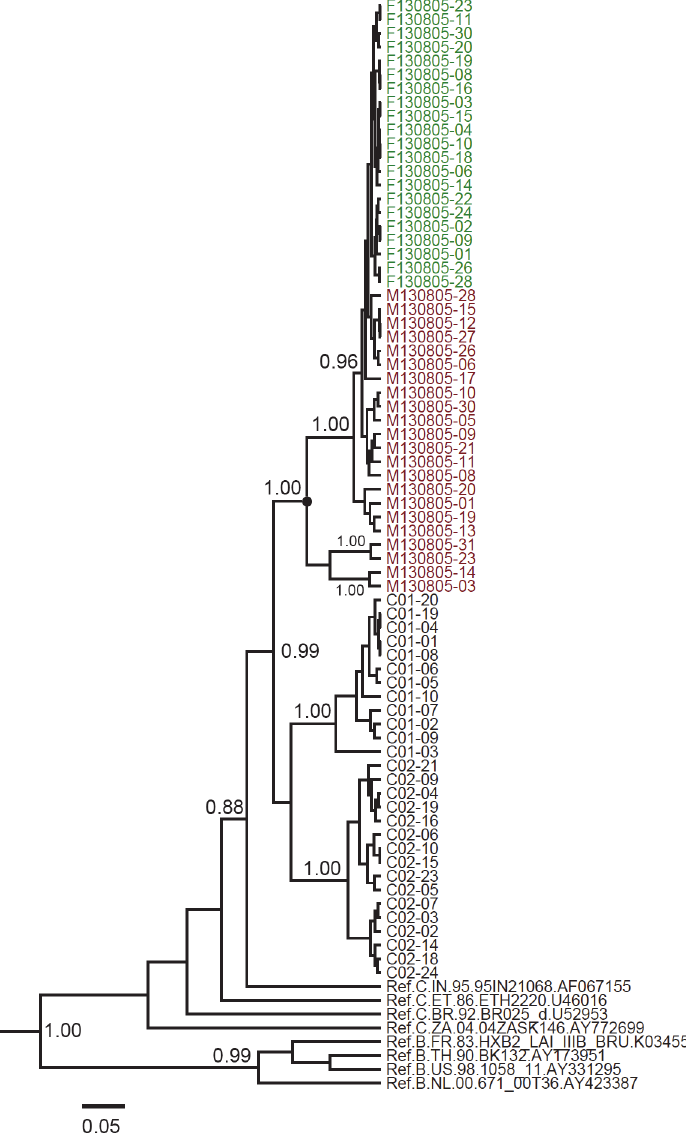
Fig 3. Maximum clade credibility (MCC) tree for env quasispecies from the subjects. The MCC trees were obtained by Bayesian MCMC analysis based on partial env gene (HXB2: 7002 – 7541) implemented in BEAST. The uncorrelated exponential relaxed molecular clock method was used in combination with the Bayesian Skyline coalescent tree prior under GTR+I+G4 nucleotide substitution model. Red taxon: the viral quasispecies from the man; Green taxon: the viral quasispecies from the woman. The posterior probabilities of the key nodes are indicated. The most recent common ancestor of sequences from the man is shown by a filled circle. The scale bar indicates 5% nucleotide sequence